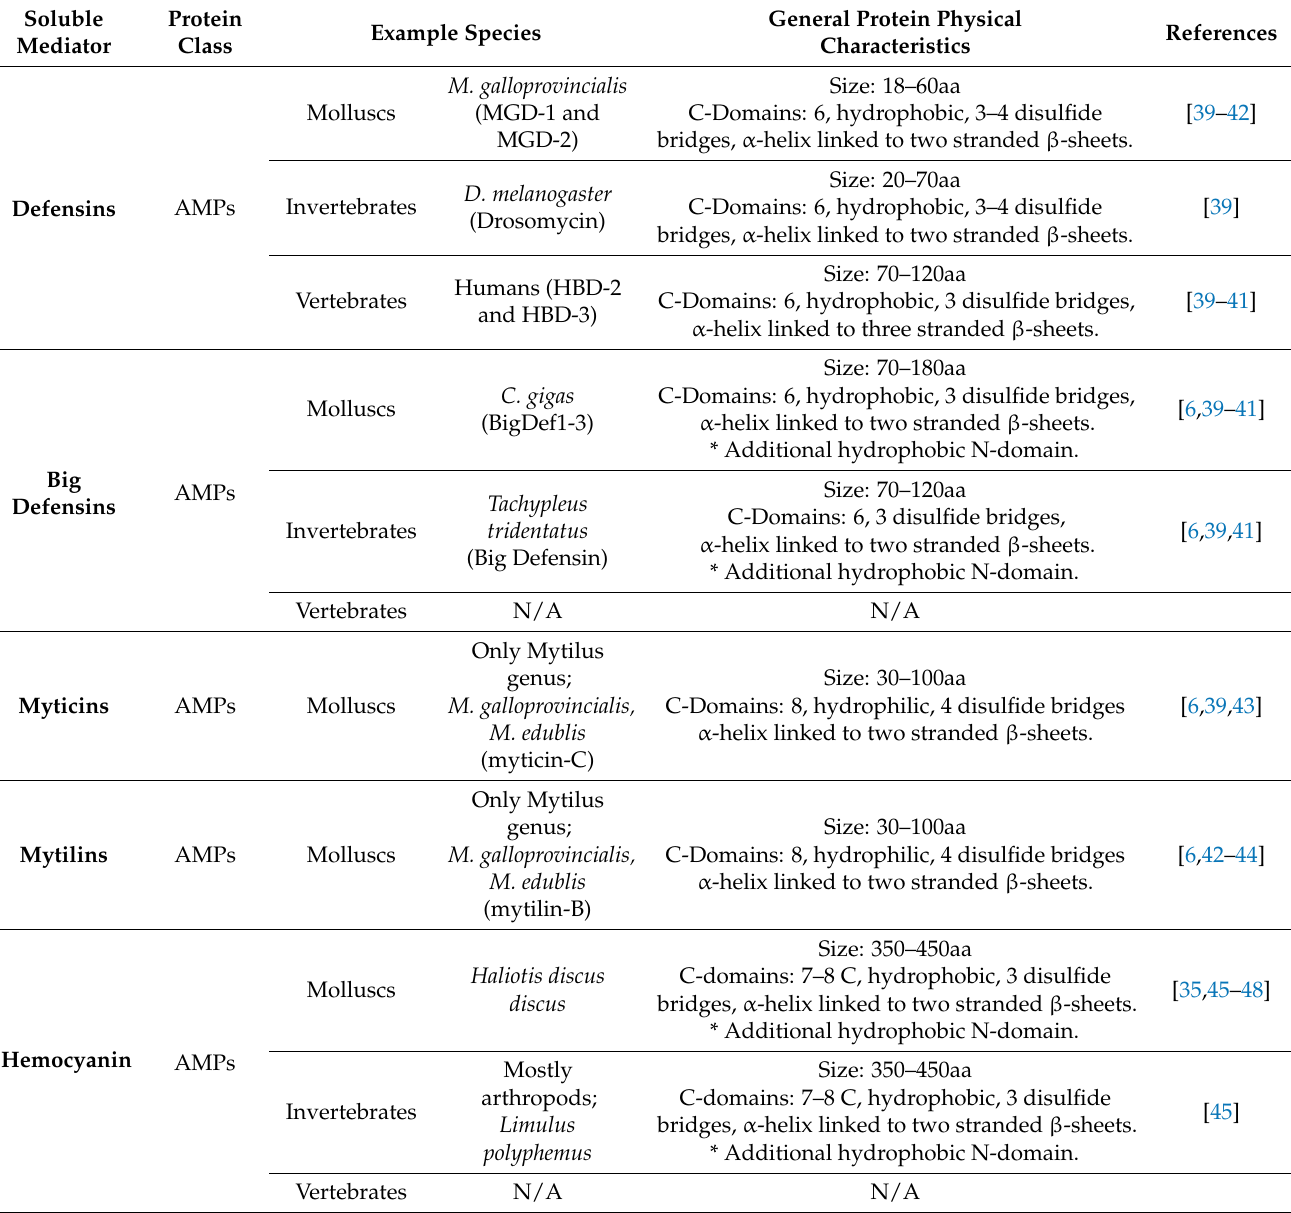
Table 1. Summary comparison of AMPs and lectins. Columns describe effector molecule, protein class, example species, protein physical characteristics, mollusc proteins with antiviral activity,